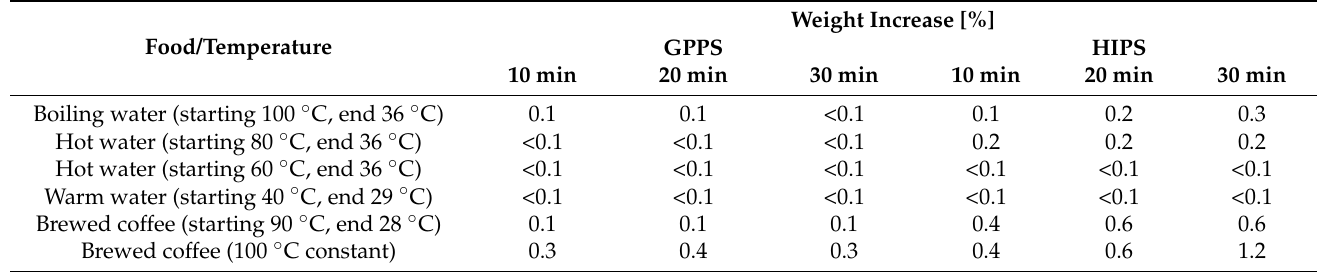
Table 5. Weight increase [%] of GPPS and HIPS in hot filled aqueous foods up to storage for up to 30 min (during cooling process or at constant